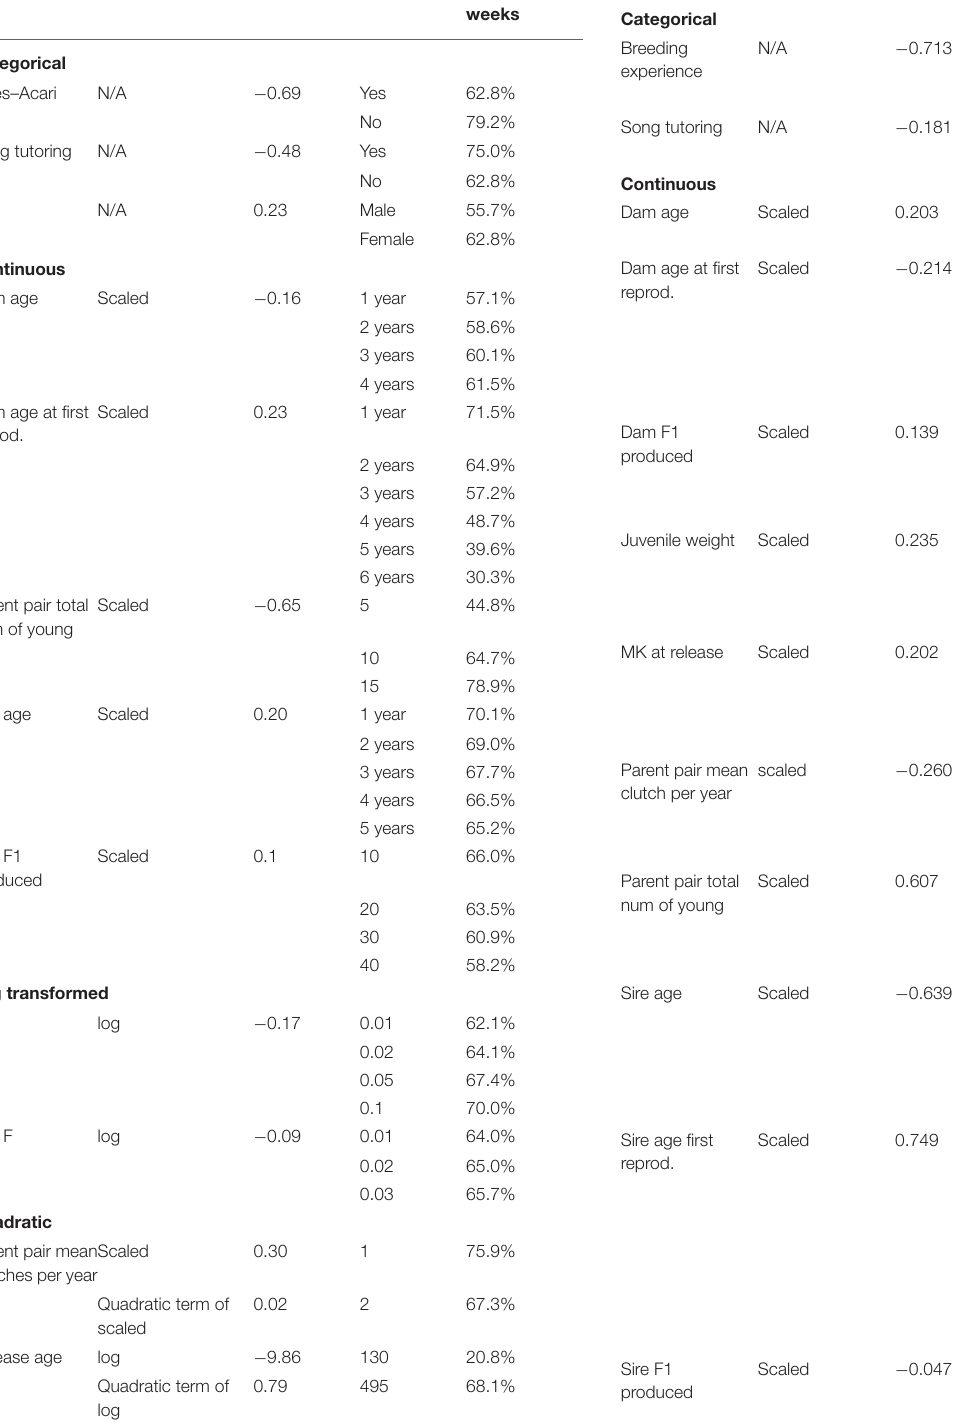
TABLE 2 | Output from Cox proportional hazards model for (transformed) TABLE 3 | Output from ordinal regression model for (transformed) variables. variables. Variable Transformation Coefficient Value Probability Variable Transformation Coefficient Value Predicted (hazard). survival at 20